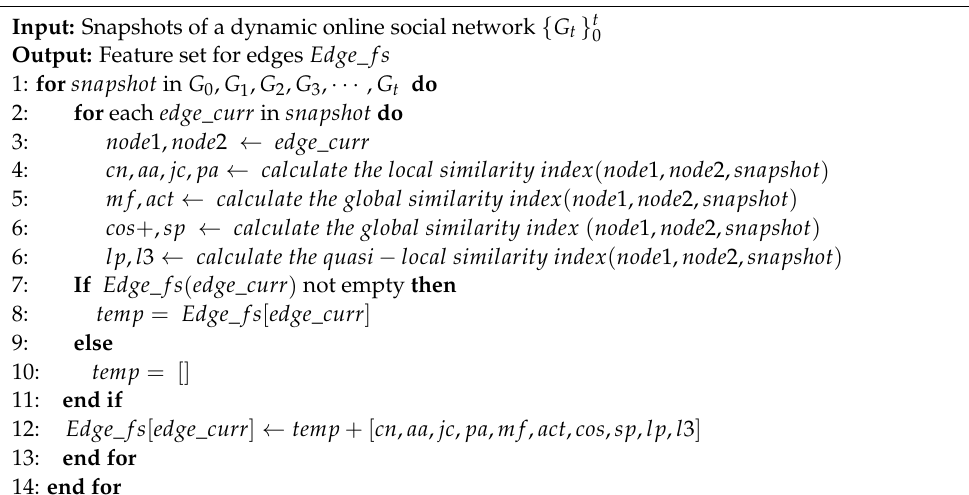
Algorithm 1 Generate the input feature vector